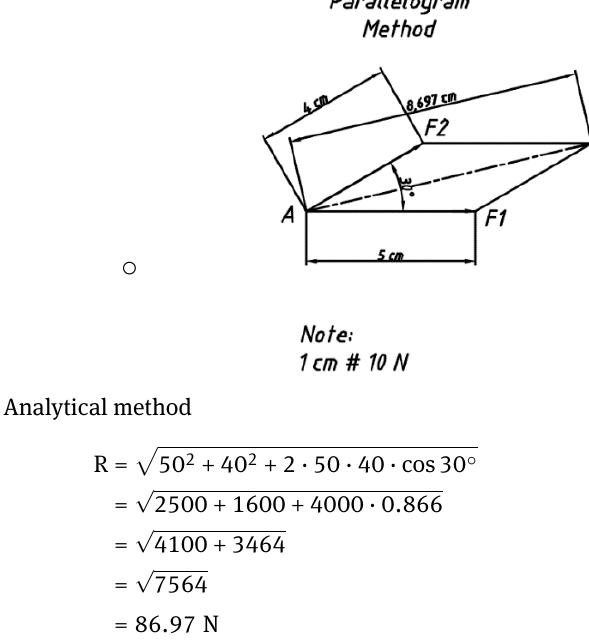
Figure 4: Activity: drawing and calculating the resultant.